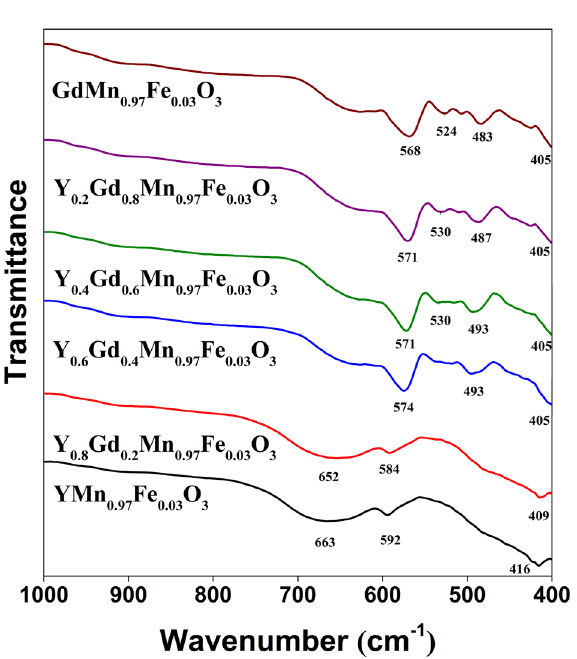
Figure 2. FT-IR spectra of Y x Gd 1−x Mn 0.97 Fe 0.03 O 3